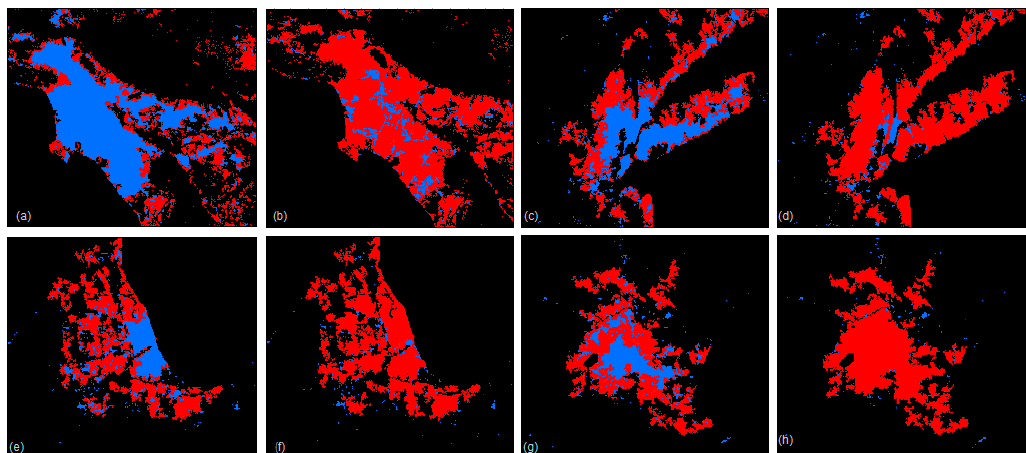
Figure 4. The comparison between building and Twitter natural cities in the four largest cities in US. (Note: Panels ( a ) and ( b ) are Los Angeles, Panels ( c ) and ( d ) are New York, Panels ( e ) and ( f ) are Chicago, and Panels ( g ) and ( h ) are Houston. The red color represents building and blue color represents the Twitter natural cities.)